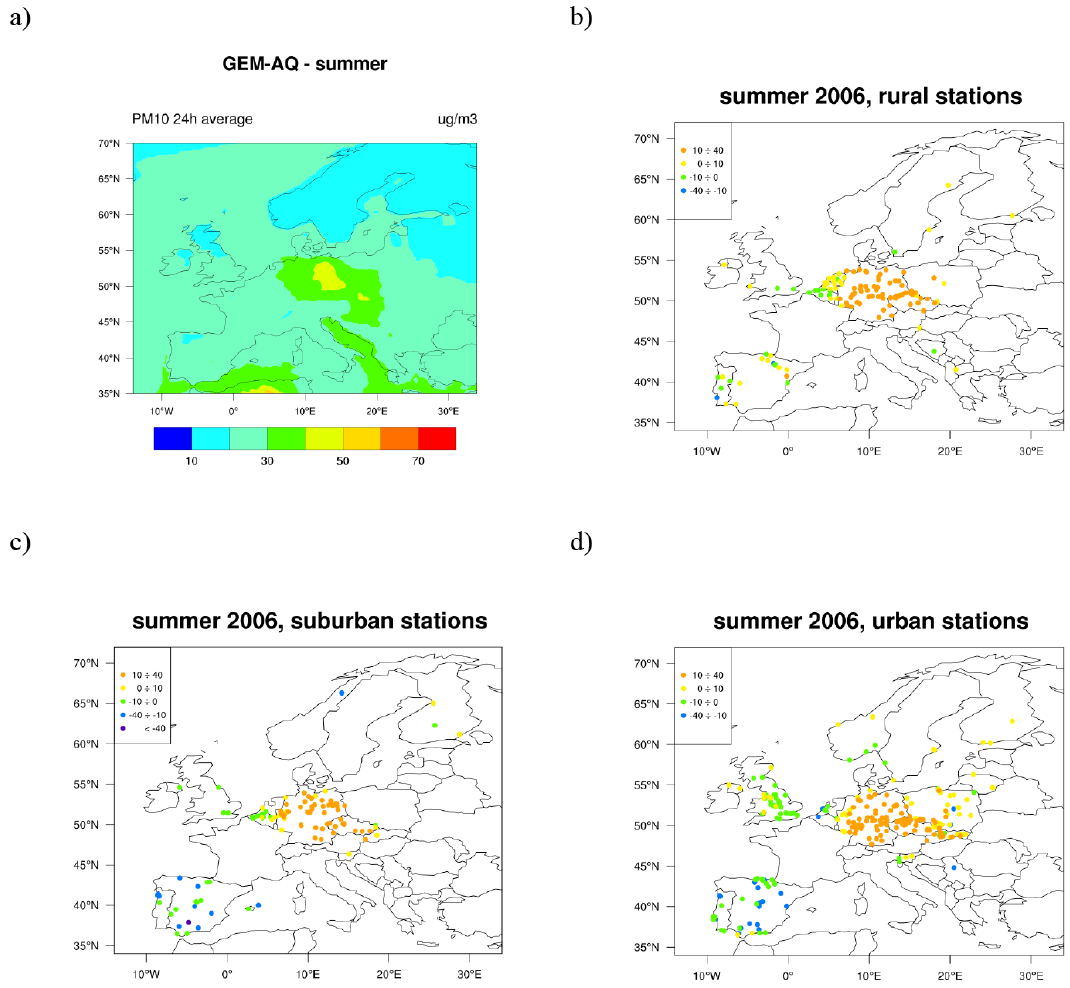
Figure 17. Summer (JJA) 24h average PM 10 concentrations in µgm − 3 (a) , MBE at rural stations (b) , MBE at suburban stations (c) and MBE at urban stations (d)